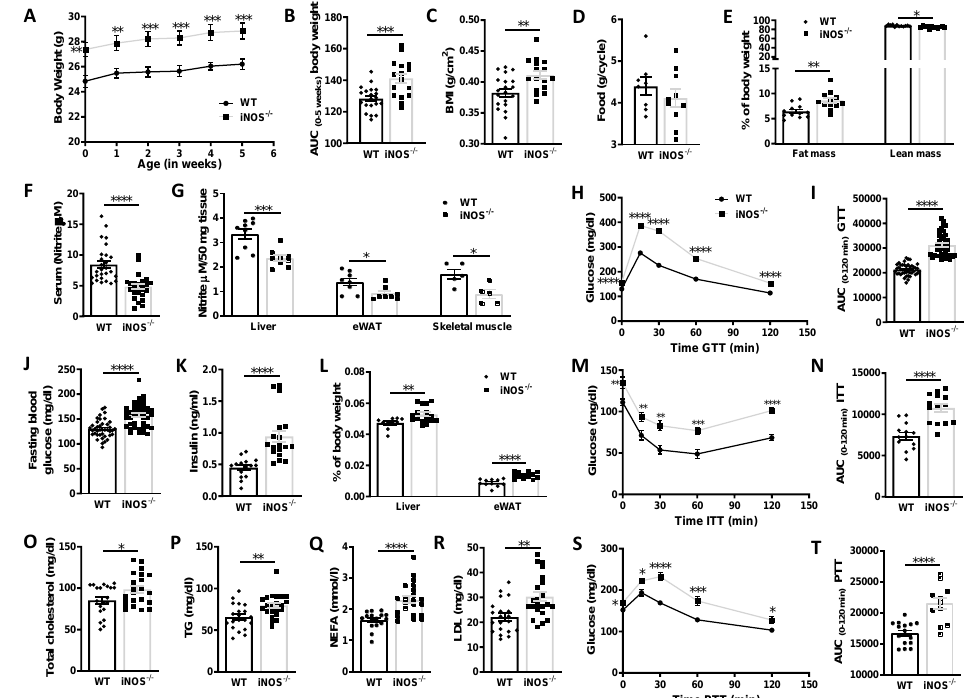
Figure 1. Grossparameters, systemicglucosetolerance, insulinsensitivity, gluconeogenesis, andcirculating Figure 1. Gross parameters, systemic glucose tolerance, insulin sensitivity, gluconeogenesis, and lipids in chow fed wild type (WT) and iNOS − / − mice. ( A ) Body weight from the initiation (0 week) to circulating lipids in chow fed wild type (WT) and iNOS −/− mice. ( A ) Body weight from the initiation study termination (5 weeks) (WT: n = 20, iNOS − / − : n = 16). ( B ) Area under the curve (AUC) (0 week) to study termination (5 weeks) (WT: n = 20, iNOS −/− : n = 16). ( B ) Area under the curve (AUC) calculated from the gradual change in the body weight of WT and iNOS −/− (WT: n = 20, iNOS −/− : n = 16) mice. ( C ) Body mass index (BMI) (WT: n = 20, iNOS −/− : n = 16), ( D ) food consumption (WT: n = 8, iNOS −/− : n = 10), ( E ) whole body fat mass and lean mass (%) ( n = 12), ( F ) total nitrite levels in serum ( n = 24), ( G ) total nitrite levels in insulin sensitive tissues — liver ( n = 9), white adipose tissue ( n = 8), and skeletal muscle ( n = 5). ( H ) Intraperitoneal glucose tolerance test (GTT) and ( I ) area under the curve (AUC) calculated from IPGTT data ( n = 40). ( J ) Fasting blood glucose levels ( n = 40), ( K ) fasting serum insulin levels (WT: n = 16, iNOS −/− : n = 18), ( L ) relative liver weight (WT: n = 10, iNOS −/− : n = 16), and epididymal white adipose tissue weight (eWAT) (WT: n = 11, iNOS −/− : n = 12). ( M ) Intraperitoneal insulin tolerance test (ITT) and ( N ) AUC calculated from ITT (WT: n = 12, iNOS −/− : n = 10). Serum lipid levels after 6 h fasting (WT: n = 16, iNOS −/− : n = 22). ( O ) Total cholesterol (TC), ( P ) triglycerides (TG), ( Q ) non-esterified free fatty acids (NEFA), ( R ) low density lipoprotein (LDL). ( S ) Intraperitoneal pyruvate tolerance test (PTT) and ( T ) AUC calculated from PTT (WT: n = 12, iNOS −/− : n = 10) in chow fed WT and iNOS −/− mice. Data are represented as mean ± SEM. Black circles: WT, black squares: iNOS −/− mice. * p < 0.05, ** p < 0.01, *** p < 0.001, **** p < 0.0001 vs. WT.